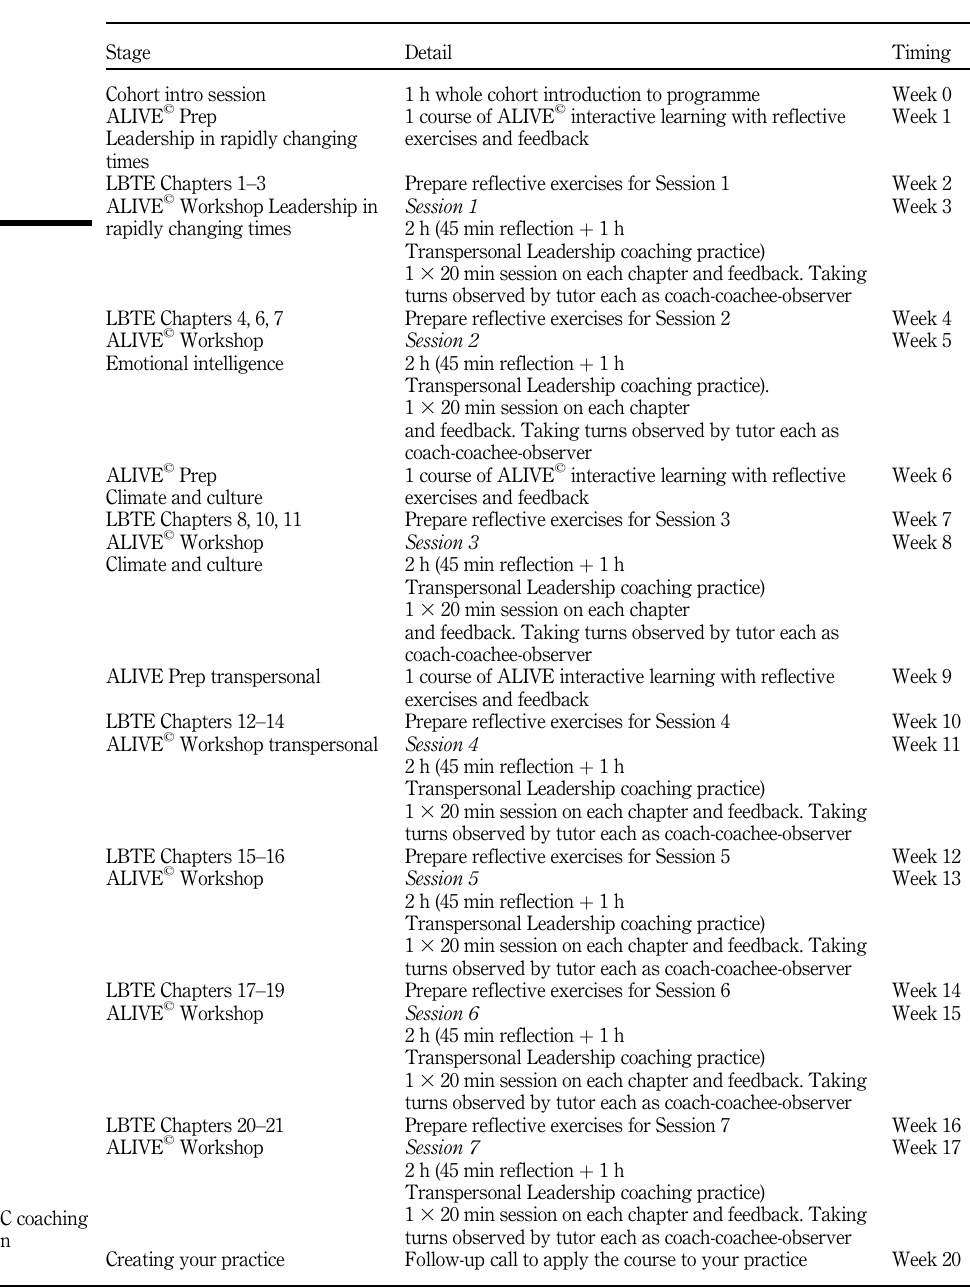
Table III. Stage 2: TLC coaching accreditation